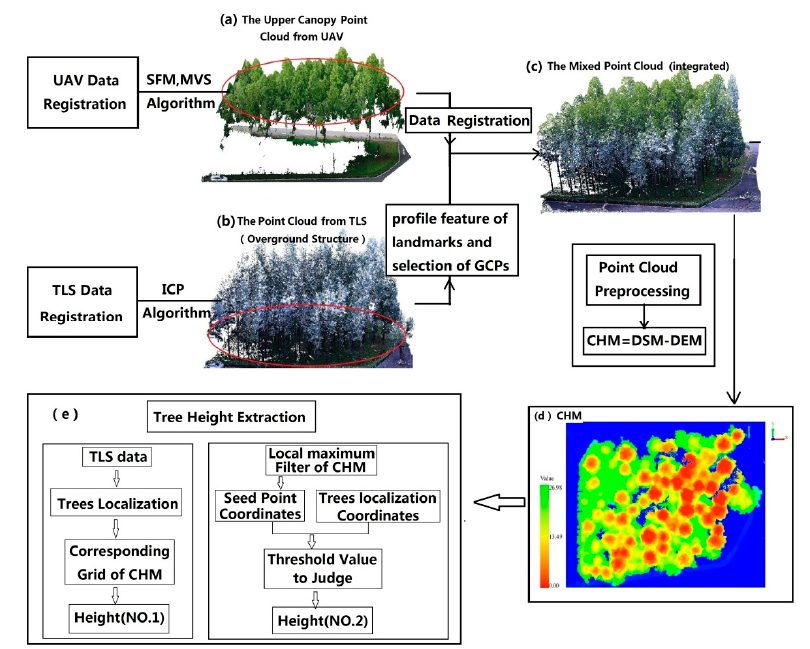
Figure 5. The flow chart of extract height of planted coniferous forests with TLS and UAV point cloud data: ( a ) UAV image-based point cloud; ( b ) TLS point cloud; ( c ) mixed point cloud; ( d ) CHM by point cloud preprocessing; and ( e ) tree height extraction method.